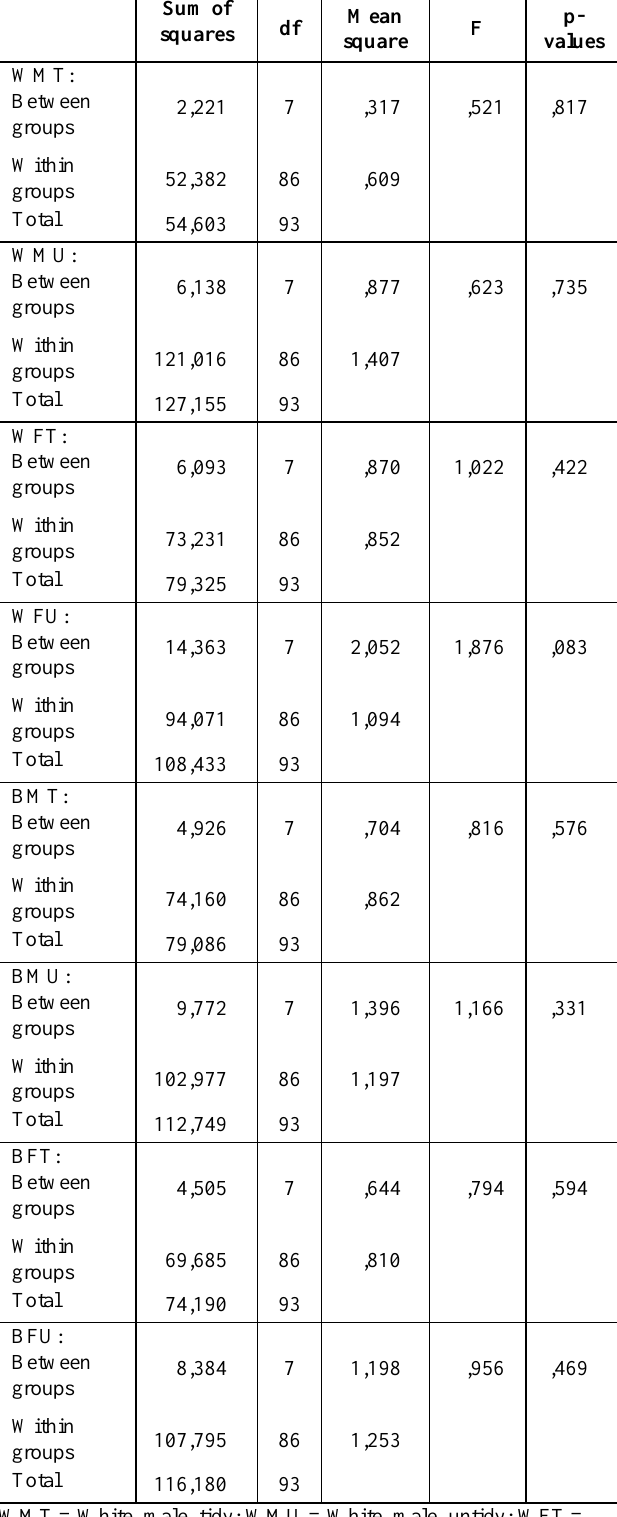
Table 9: ANOVA results: Three-way interaction between gender, race and